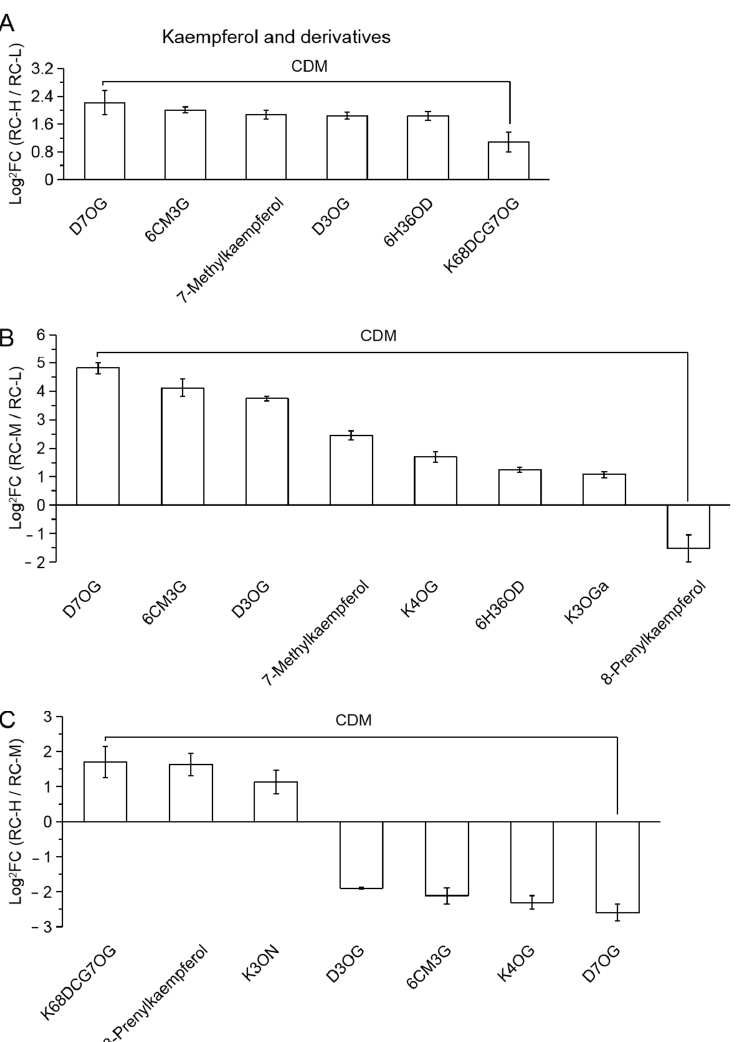
Figure 8. Comparison of differential metabolites of kaempferol and its derivatives between RC-L, RC-M and RC-H. These were 6 CDMs for RC-H vs. RC-L ( A ), 8 CDMs for RC-M vs. RC-L ( B ), and 7 CDMs for RC-H vs. RC-M ( C ), respectively. Upregulation denotes that the content of a metabolite in RC increased with elevation between two altitudes, and the opposite for downregulation. The Y-axis is shown as Log 2 FC values for the convenience of visual presentation (Note: The up-amplitude in the text refers to the FC value). The X-axis denotes metabolite names. Meanwhile, the number of differential metabolites of kaempferol and its derivatives was 6, 8 and 7 in the comparisons of RC-H vs. RC-L, RC-M vs. RC-L, and RC-H vs. RC-M. Within the range of variation, kaempferol and its derivatives accounted for the second highest significant variation in flavonoid metabolites in Rhodiola crenulata with 16.22% of 37, 14.29% of 56 and 18.92% of 37 in the total number of flavonoid differential metabolites, respectively, slightly lower than quercetin and its derivatives. In RC-H vs. RC-L, seven CDMs were classified into the class of catechin and deriva- tives. These 7 substances are presented in Figure 9A in descending order from left to right